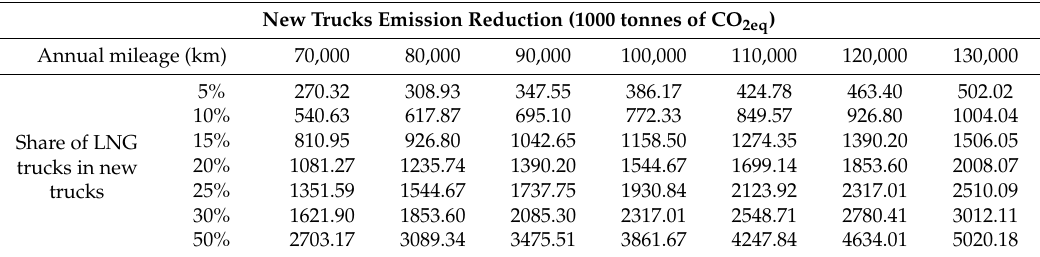
Table 5. GHG emission reduction for different LNG truck shares on EU level.